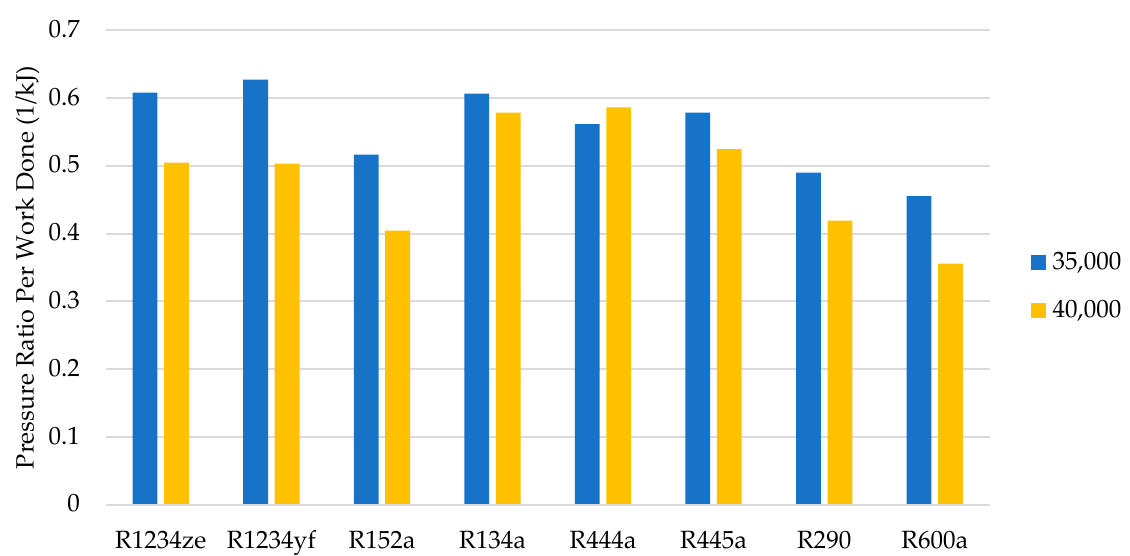
Figure 16. Comparison of Pressure Ratio Increase Per Specific Work Done by the Compressor Based on 1 kg of Fluid. Table 5. Pressure Ratio Increase Per Specific Work Done by the Compressor Based on 1 kg of